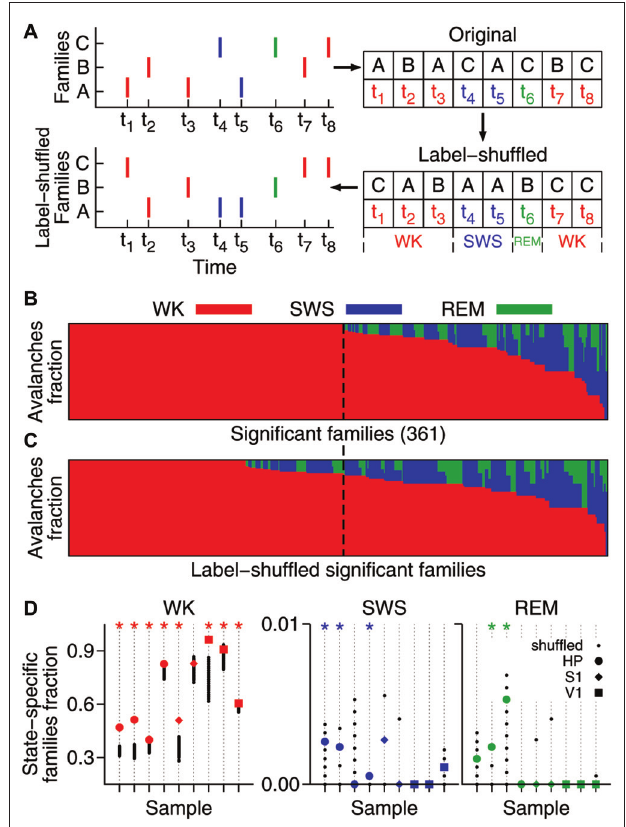
FIGURE 2 | A significant fraction of the avalanche repertoire occurs exclusively during waking. (A) To assess the significance of the results, significant families were subjected to the shuffling of family labels. This procedure preserves the distribution of family sizes (see Figure 1D ), the number of avalanches in each behavioral state, and the times of occurrence of each avalanche. (B) Fraction of avalanches occurring during waking (WK), slow-wave sleep (SWS) and rapid-eye-movement sleep (REM) for each of the 361 significant families of one sample (ranked by WK and then SWS prevalence). The dashed line indicates the boundary that separates waking-specific families from other families. (C) Same as in (B) , but for families obtained from one single label-shuffled set. Note that many shuffled families comprising multiple states fall to the left of the dashed line, indicating that the number of the non-shuffled families that are waking-specific is larger. (D) For each data sample (animal/brain region), the fraction of state-specific families is compared to 1000 shuffled sets. Asterisk indicates significant results ( p = 0.05). While the state specificity of families that occur during sleep is limited (3/9 samples in SWS and 2/9 in REM), waking-specific families occur significantly in 8/9